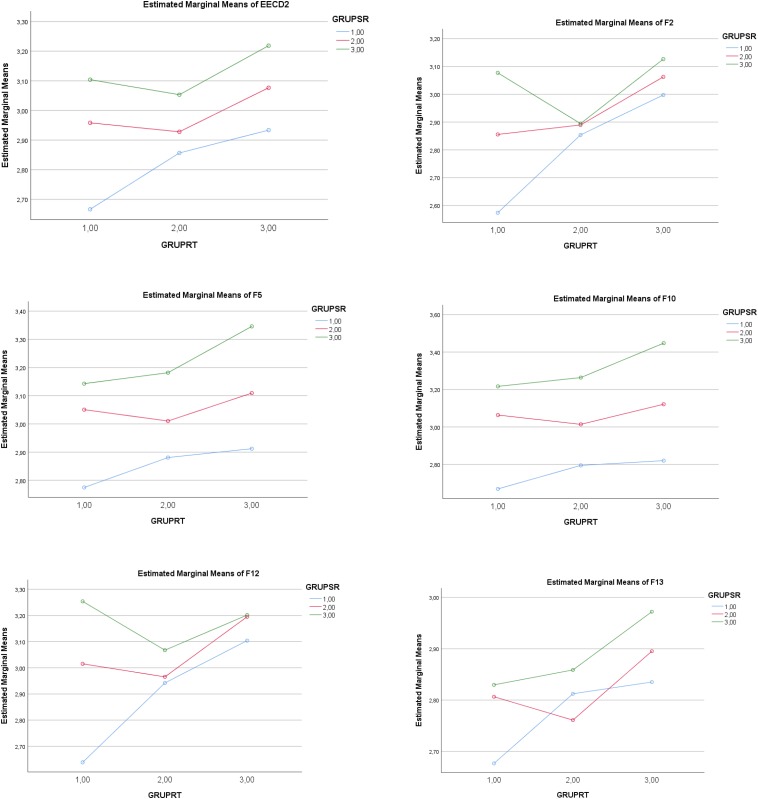
Graphic representation of the effect of low(1)–medium(2)–high(3) levels in the IV Self-regulation (GRUPSR) and low(1)–medium(2)–high (3) levels in the IV Regulatory Teaching (GRUPRT) on Problem-focused Coping StrategiesEECF2. Seeking help; EECF5. Self-Instructions; EECF10. Positive re-appraisal; EECF12. Communicating feelings; EECF13. Alternative reinforcement.